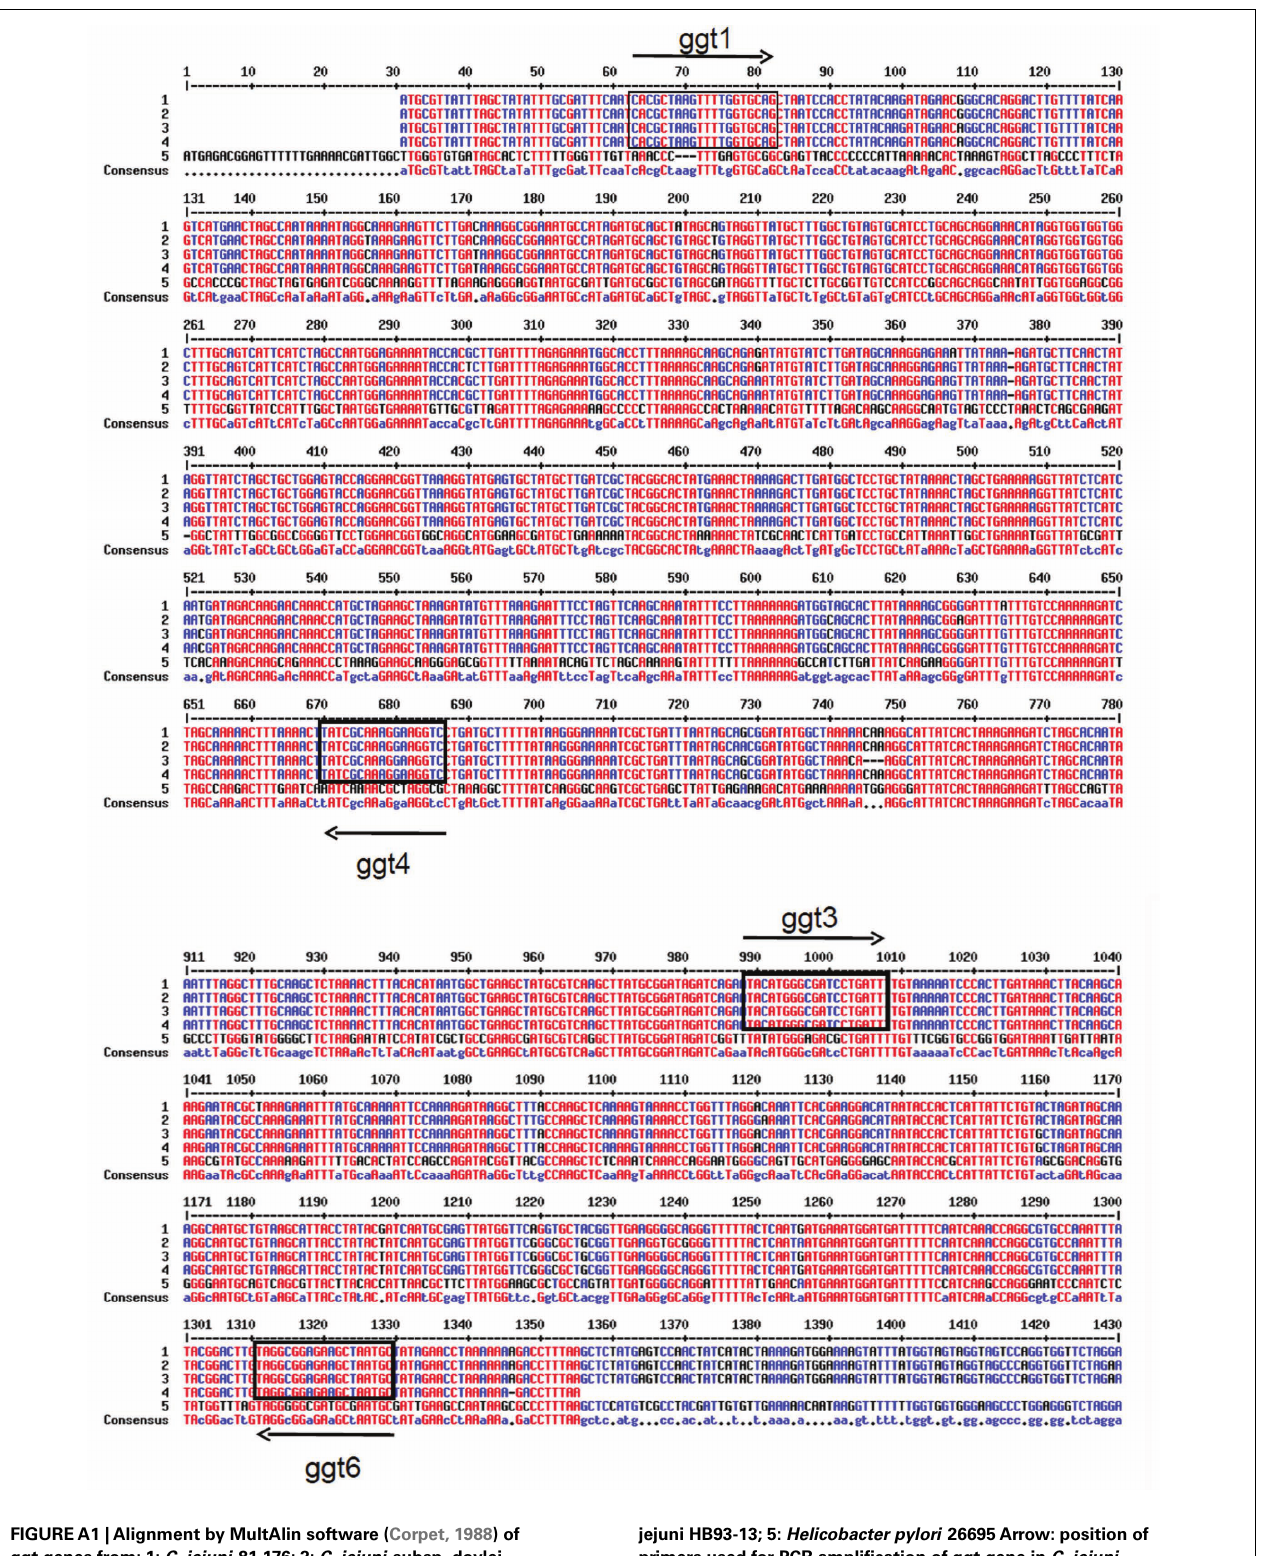
FIGUREA1 |Alignment by MultAlin software (Corpet, 1988) of ggt genes from: 1: C. jejuni 81-176; 2: C. jejuni subsp. doylei 269.97; 3: C. jejuni subsp. jejuni 260.94, 4: C. jejuni subsp.